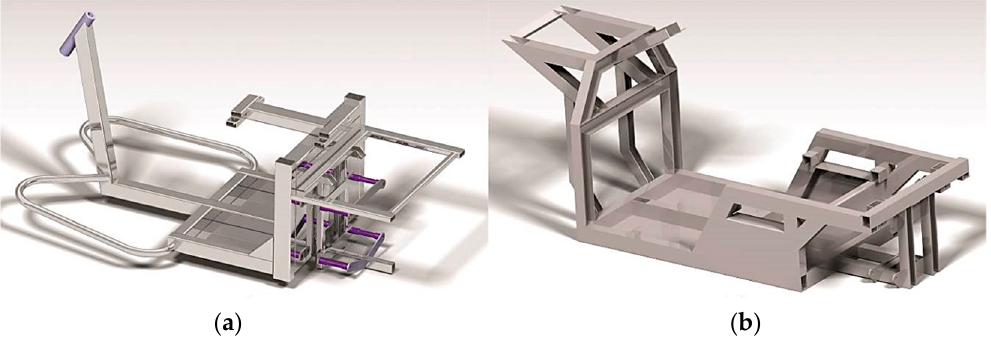
Figure 1. Frame comparison: ( a ) a steel frame of the commercial electrical three-wheeled vehicle; ( b ) a design solution of the frame from the alloy EN AW 6063.T66 for the designed three-wheeled vehicle.